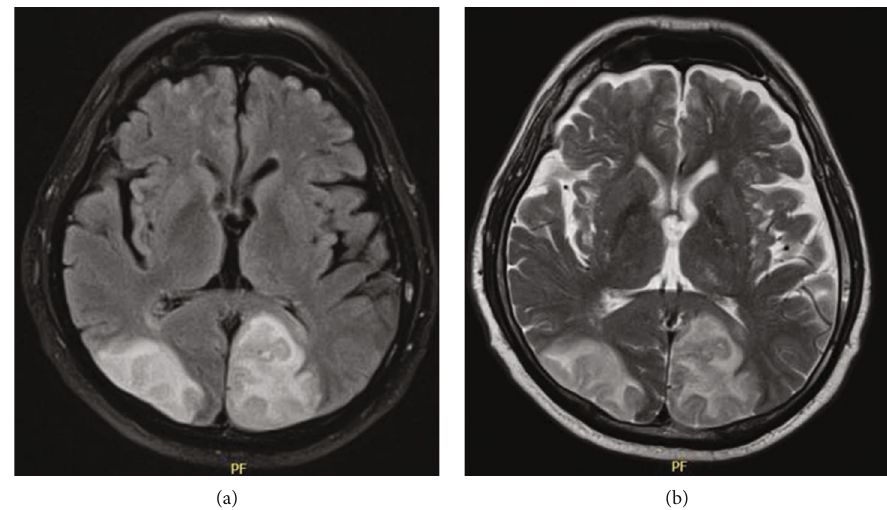
Figure 2: Brain MR of case 2. (a) Fluid-attenuated inversion recovery sequence showing extensive bilateral asymmetrical occipital hyperintensities in the occipital lobe and (b) its representation on T2-weighted